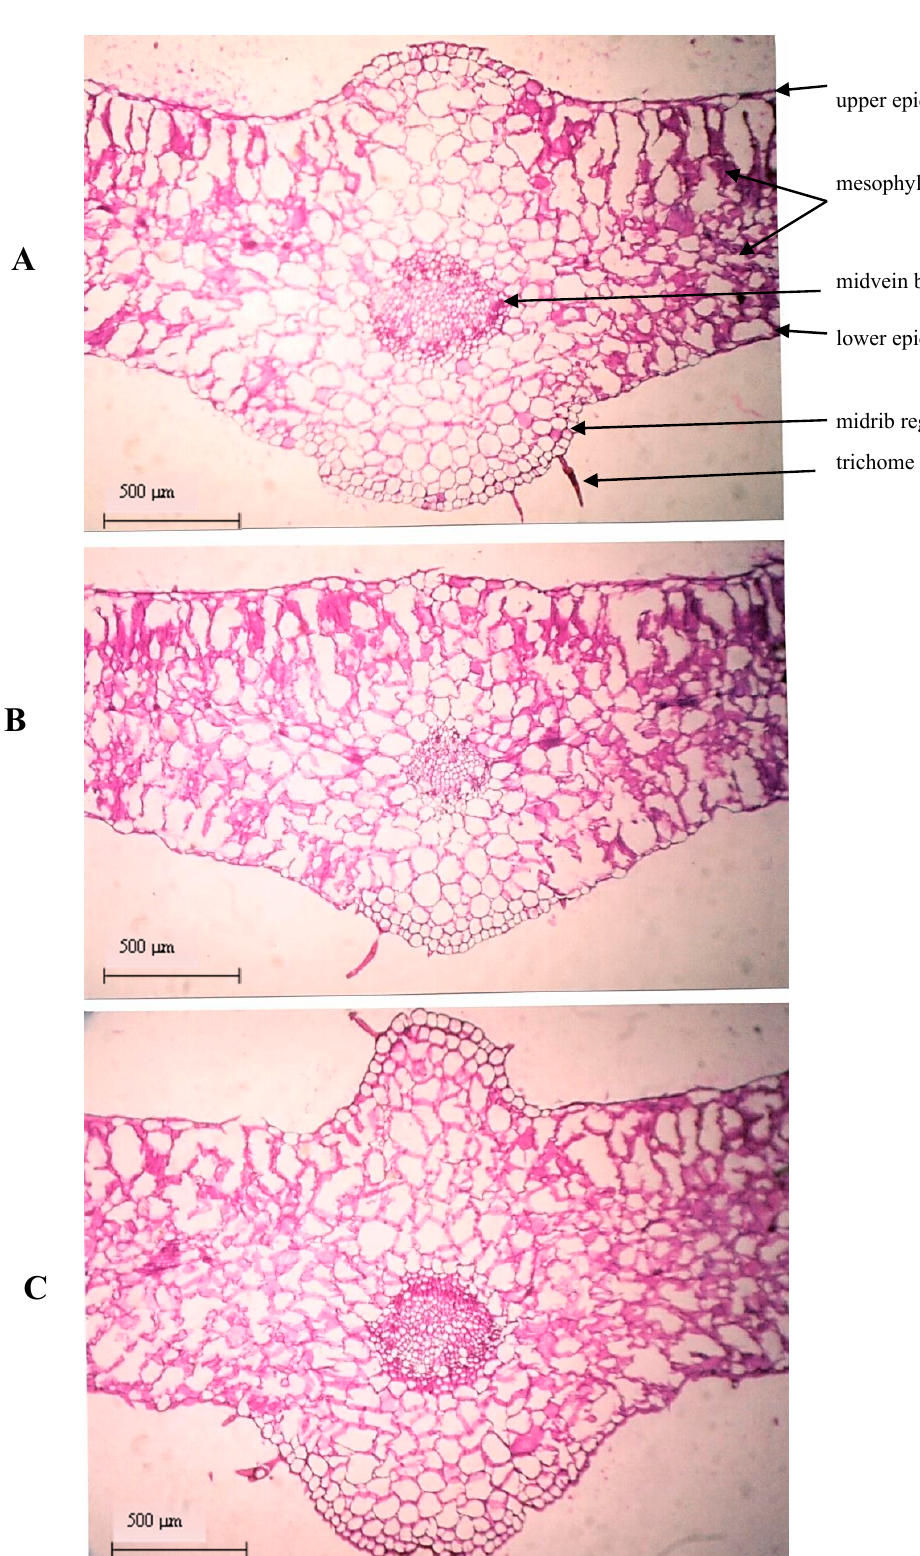
Figure 2. Transverse sections of leaf blade taken from the middle part of Egyptian henbane main stem 90 days after sowing, as affected by N fertilizer and Rhizobacterein. ( A ), control plant received 120 kg N ha − 1 ; ( B ), plant received 60 kg N ha − 1 ; ( C ), plant received 60 kg N ha − 1 plus Rhizobacterein ® .